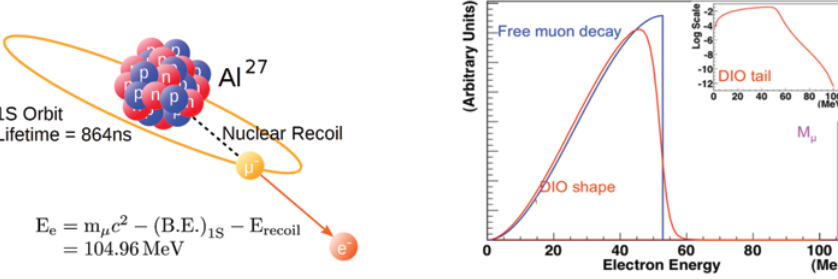
Figure 3. (Left) Sketch of the muon to electron conversion process. (Right) Energy spectrum for electrons produced from muon decays in orbit. The spectrum is a modified Michel spectrum with a long tail that falls quickly as ( E e − E endpoint ) 5 and comes in proximity to the kinematic endpoint. Perfect resolution is